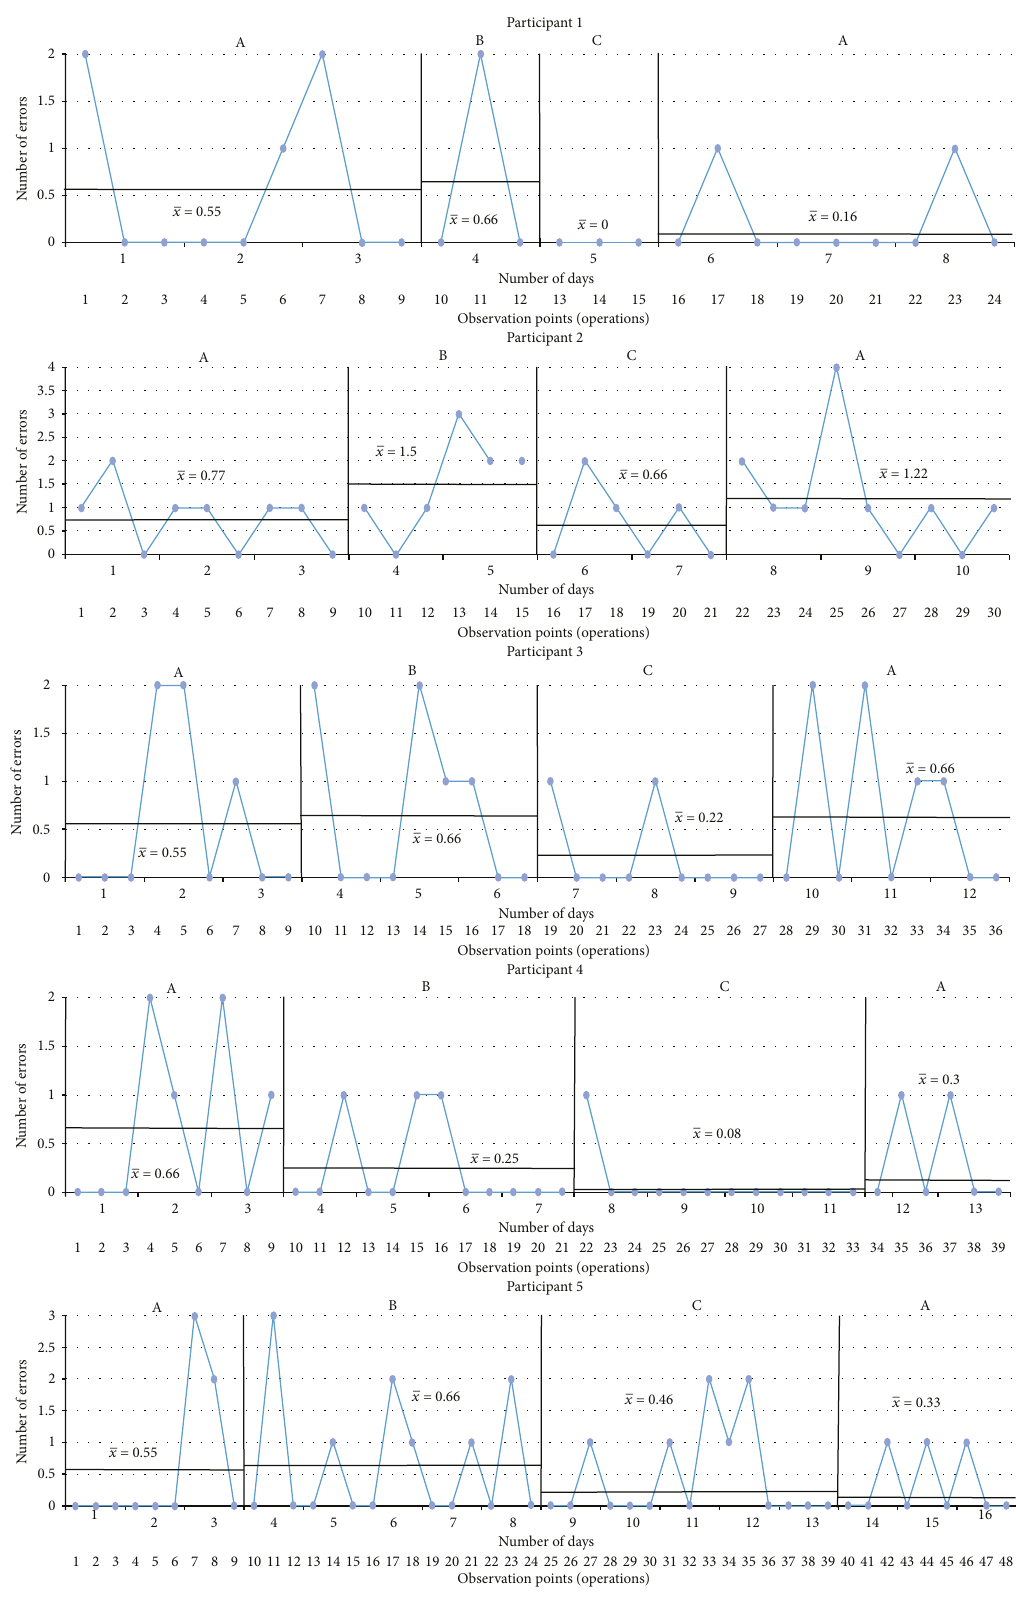
Figure 5: Additional question. A: baseline; B: sham tDCS; C: tDCS; x -axis: observation points in number of tasks performed within days; y -axis: number of errors. Scores are shown, along with black lines marking the average of each